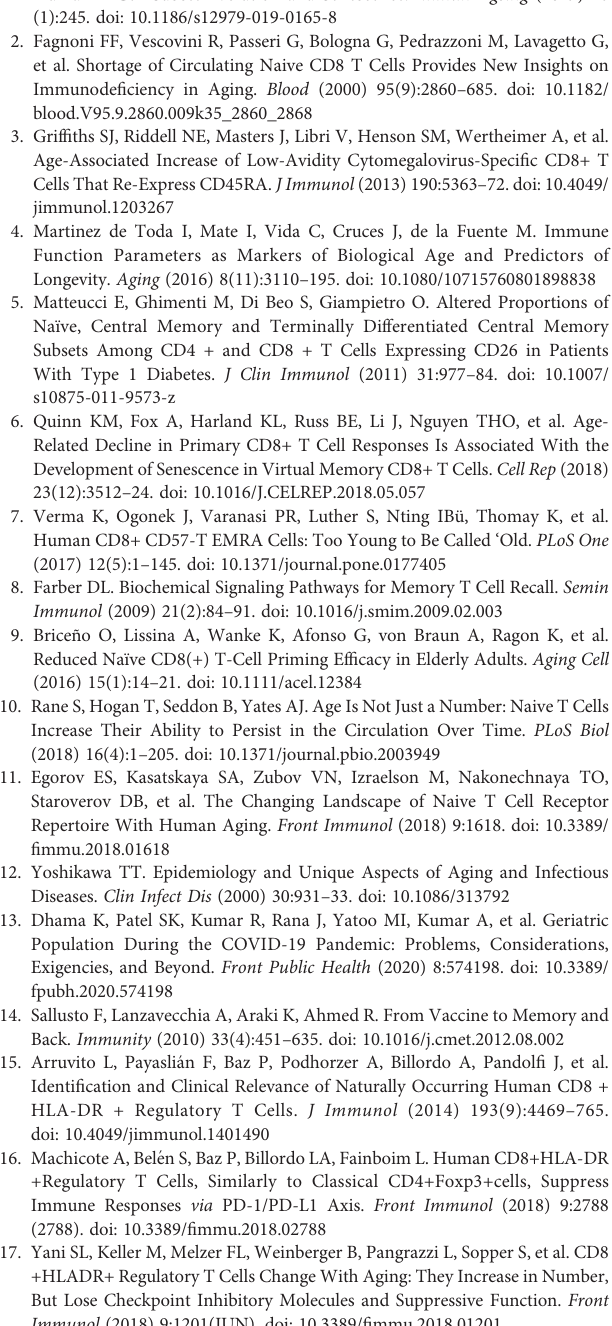
Supplementary Figure 3 | Principal Component Analysis of the transcriptomic pro fi les of the total CD8 + T cell population and the CD8 + CD45RA - memory T cell subpopulation from young and old donors divided by gender. (A) . PCA for the total CD8 + T cell preparations. Total CD8 + T cells from young female donors are light red squares, young male donors light